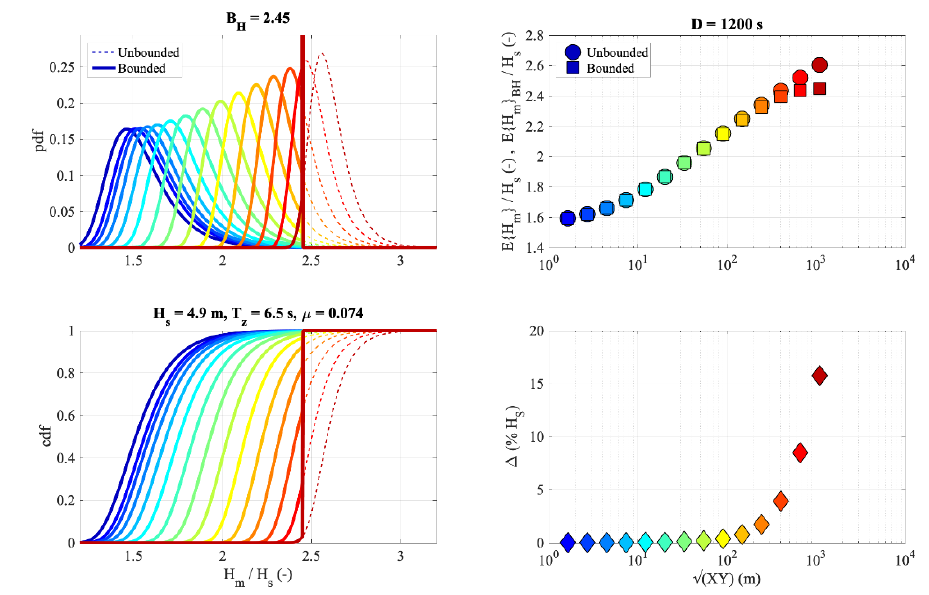
Figure 2. Space-time extreme wave heights H m . Example of unbounded Gumbel-like distribution and bounded distribution by imposing the upper bound max { H m } = 2.45 H s ( B H = 2.45; see Section 3 for the choice of the threshold value). The temporal interval duration for extreme assessment is fixed to D = 1200 s, whilst the sea surface area XY changes. (top-left) Unbounded (dashed line) and bounded pdf (solid line) color-coded from blue to red with growing sea surface area width ( XY ) 1 / 2 as in the top-right panel. (bottom-left) Unbounded (dashed line) and bounded cdf (solid line) with the same color code as the pdf. (top-right) Variation with ( XY ) 1 / 2 of normalized E{ H m } and E{ H m } BH , and (bottom-right) percentage relative error ∆ = (E{ H m } − E{ H m } BH ) / H s . Parameters of the distributions are computed using a directional wave spectrum ( H s = 4.9 m; T z = 6.5 s; µ = 0.074) obtained by running the wave